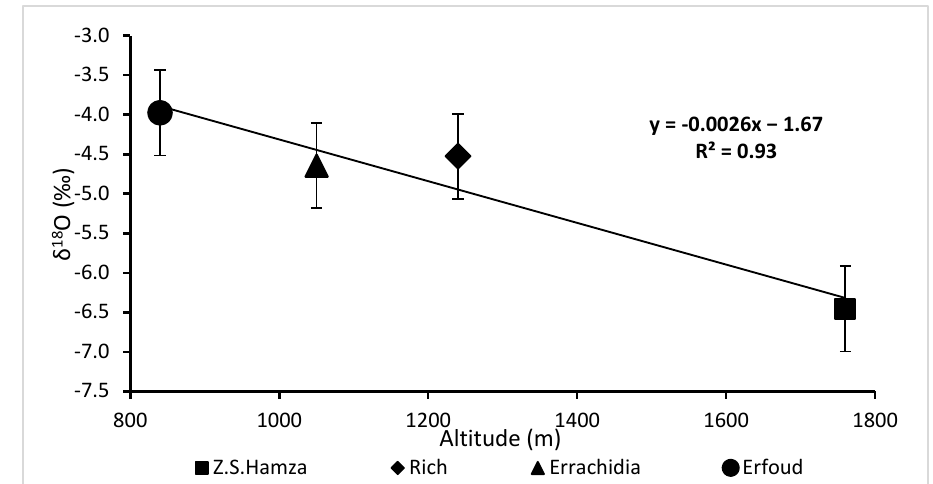
Figure 12. Altimetric gradient of the weighted means in δ 18 O according to the altitude.